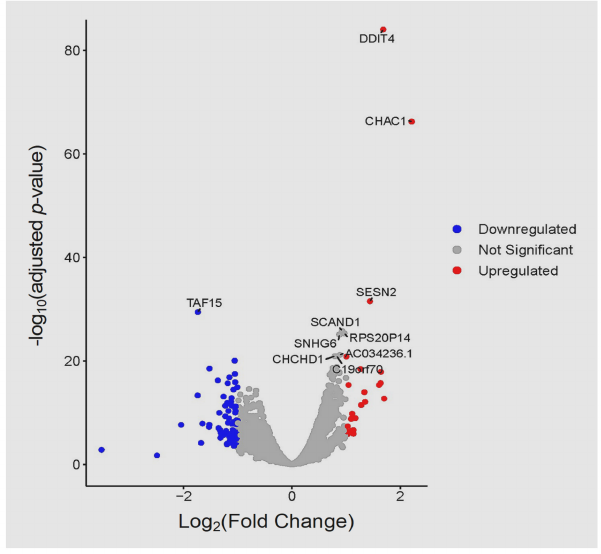
Figure 9. Volcano plot comparing the top 10 DEGs, with the highest differences in expression, between infected and control samples at 6 hpi. Upregulated (red) and downregulated (blue) genes are shown. The fold-changes in gene expression between samples (log 2 FC) are plotted on the x -axis and the y -axis shows statistical significance of the differences ( p -values). Each dot in the plot represents one